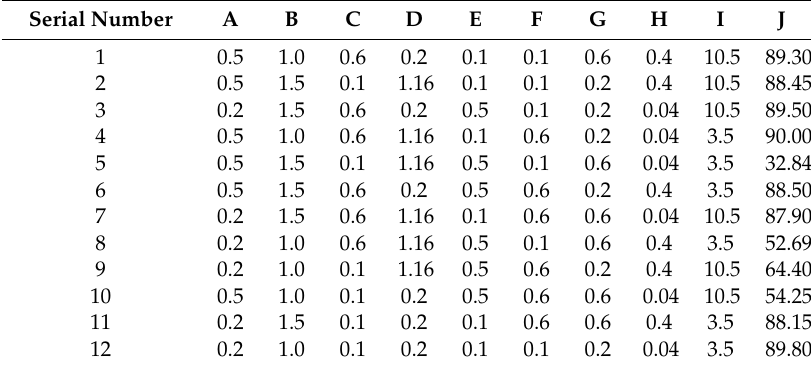
Table 4. Plackett-Burman experiment design.